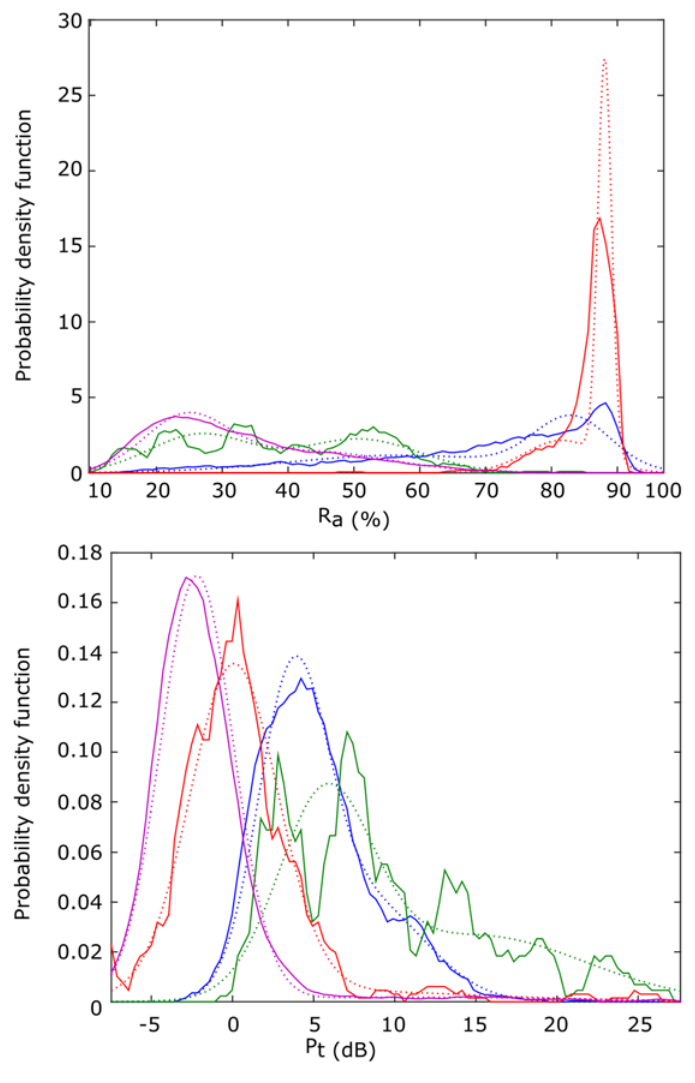
Figure 13 . Cont. Figure 13. Cont